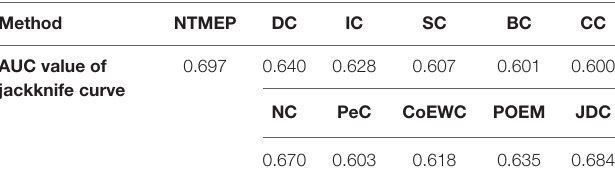
TABLE 3 | The AUC values of jackknife curve obtained from NTMEP and other 10 methods.